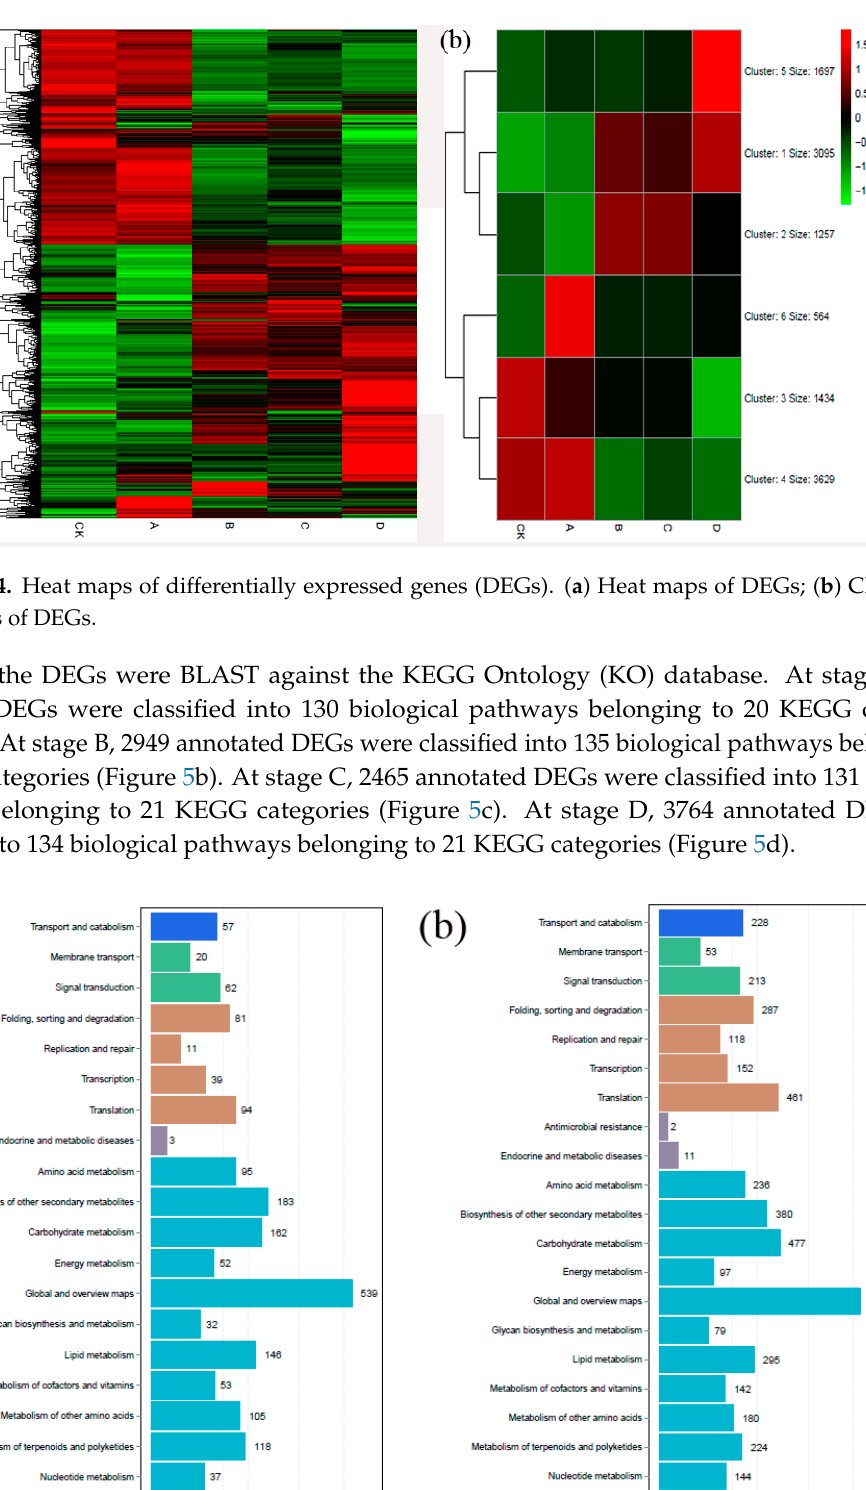
Figure 5. KEGG analysis of DEGs. ( a ) KEGG analysis of DEGs at stage A; ( b ) KEGG analysis of DEGs at stage B; ( c ) KEGG analysis of DEGs at stage C; ( d ) KEGG analysis of DEGs at stage D. We also used the Benjamini and Hochberg (BH) multiple test correction to analyze KEGG enrichment for all of the DEGs in four stages ( p < 0.05, FDR < 0.05). Enrichment of “plant–pathogen interaction”, “Plant hormone signal transduction”, and “phenylpropanoid biosynthesis” was found with a threshold of false discovery rate (FDR) < 0.05 (Figure 6). Furthermore, sesquiterpenoid and triterpenoid biosynthesis; stilbenoid, diarylheptanoid, and gingerol biosynthesis; flavonoid biosynthesis; and peroxisome were also found with a threshold of p < 0.05 (Figure 6).